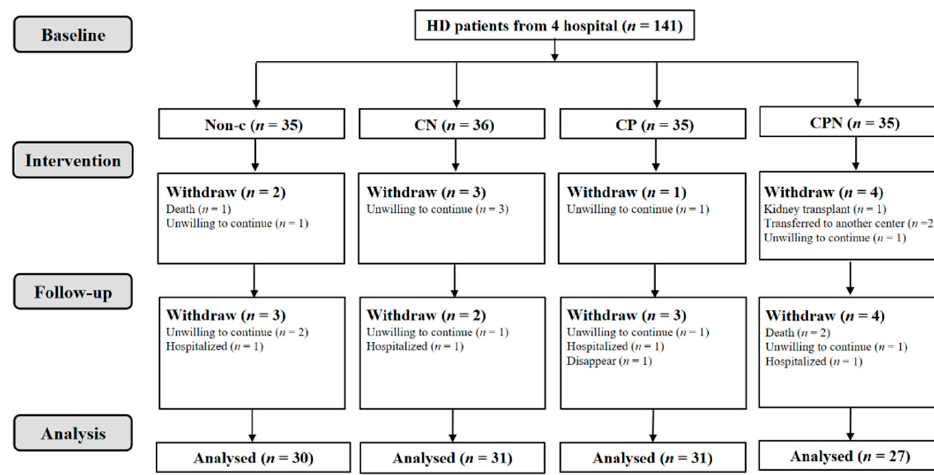
Figure 1. Flowchart of HD patients.